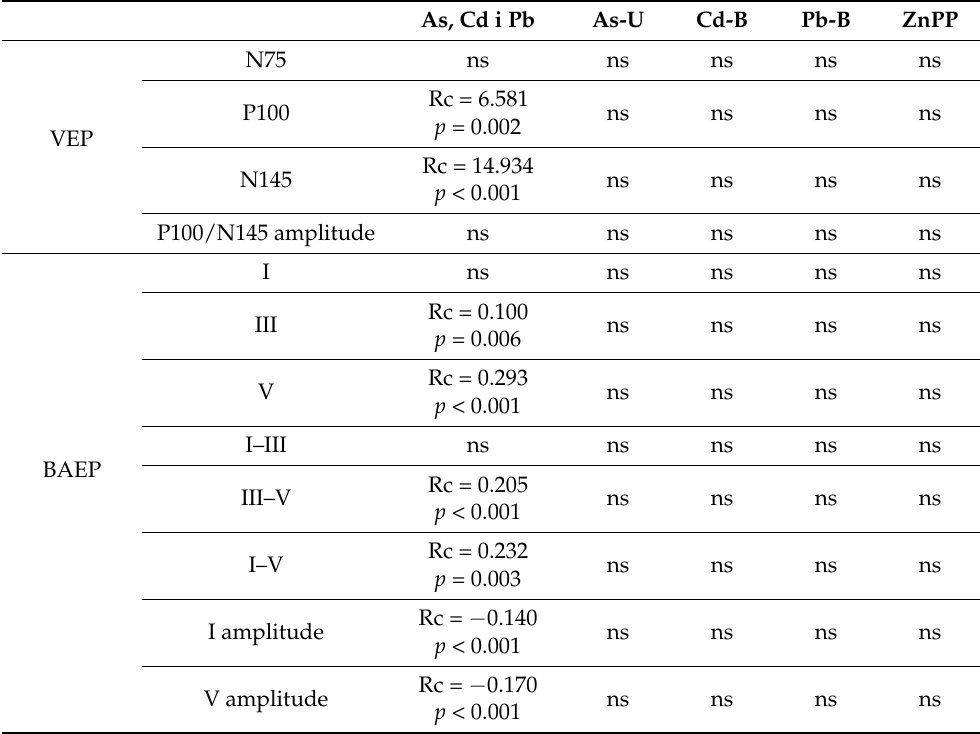
Table 5. Results of univariate regression analyses in the study